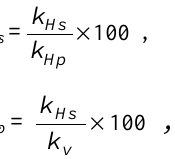
Fig 2. Algorithm diagram of altitude transfer to underground utilities